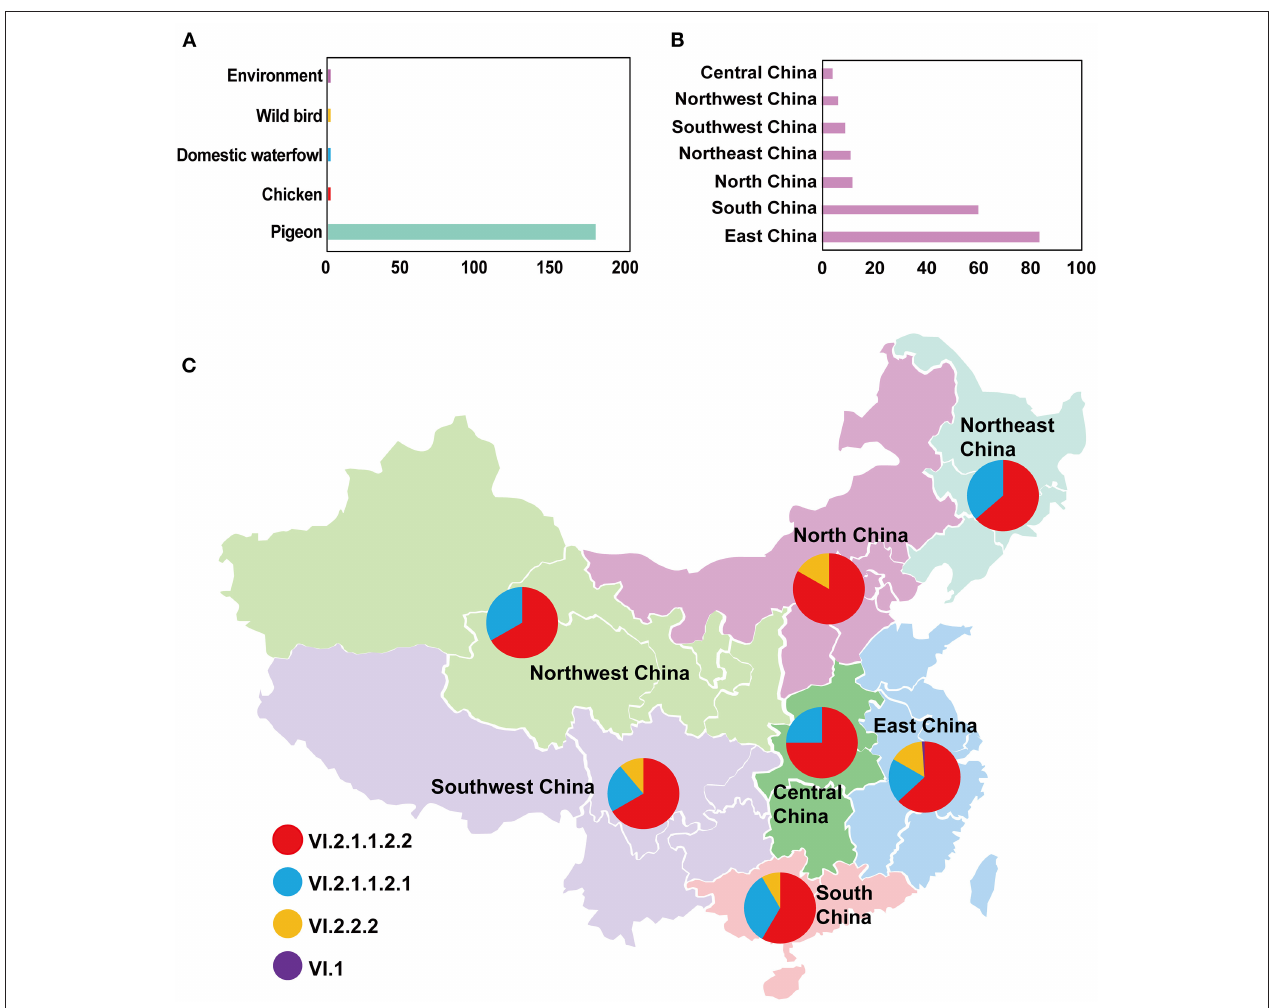
FIGURE 4 | The detailed information of PPMV-1 isolates prevailing in China. (A) The host source of all PPMV-1 isolates from China; (B) The distribution of PPMV-1 strains isolated from China; (C) The proportion of sub-genotypes of PPMV-1 isolates in different regions of China.